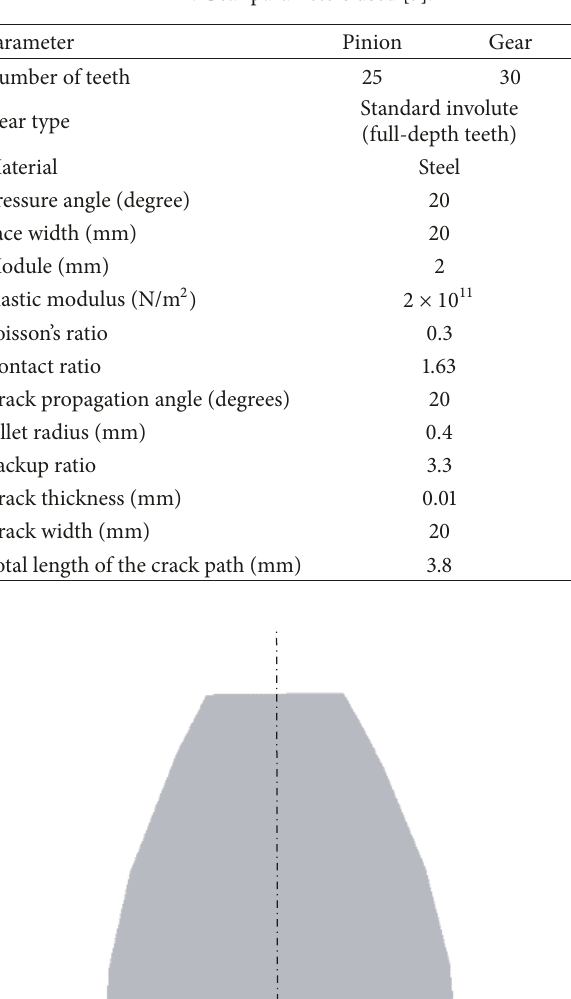
Table 2: Crack propagation